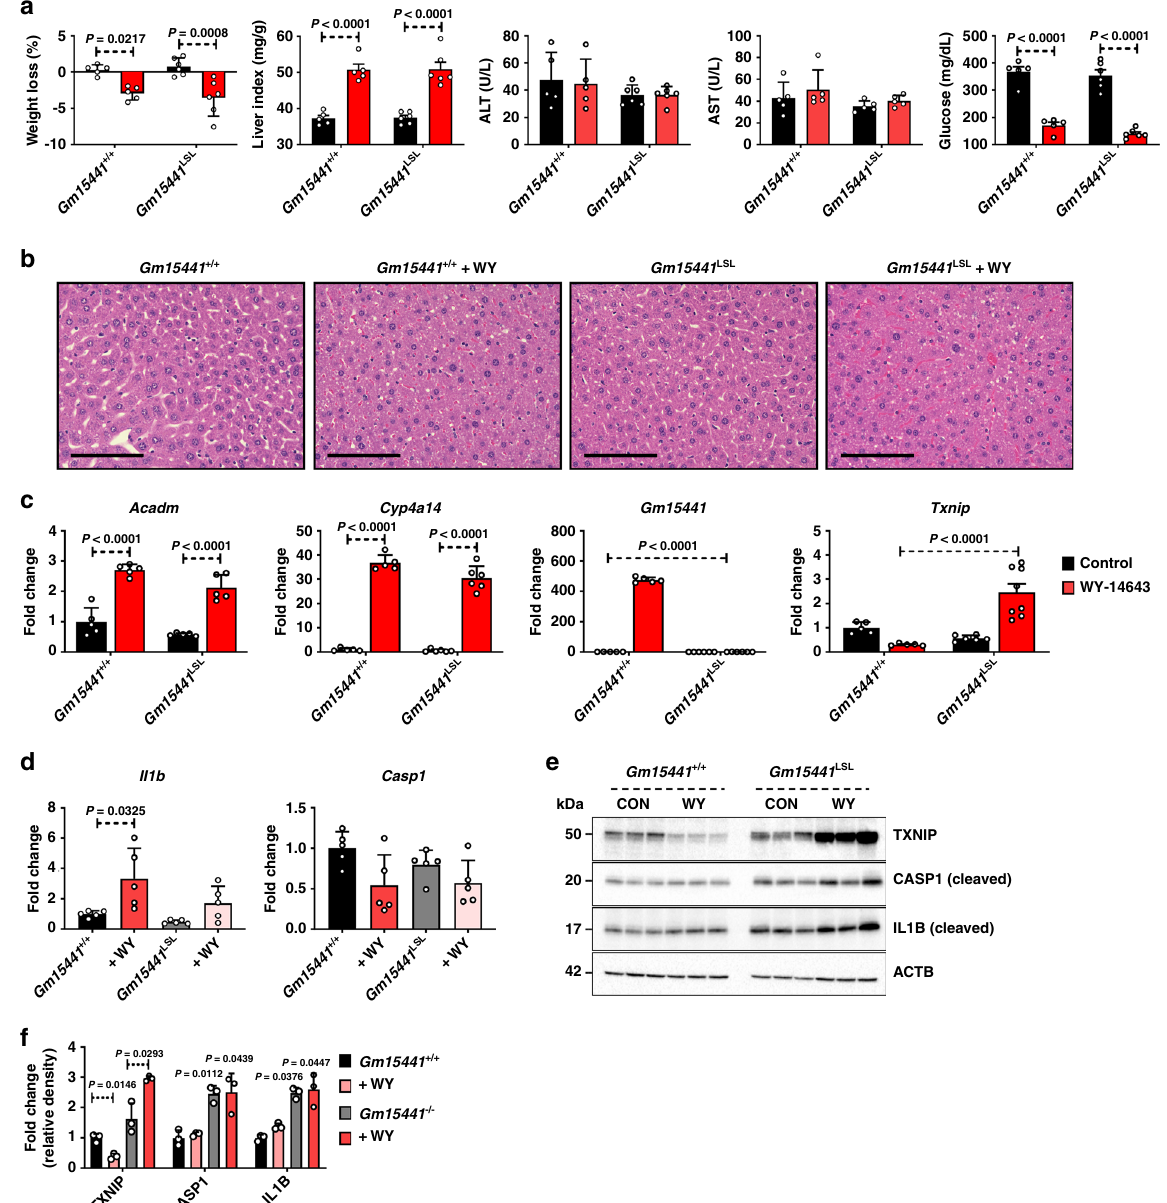
Fig. 5 Loss of Gm15441 potentiates in fl ammasome activation by WY-14643. a Physiological endpoints from Gm15441 + / + and Gm15441 LSL mice treated with WY-14643 for 48 h. Weight loss and liver indices (mg liver/g body mass; a measure of hepatomegaly), as well as serum ALT, AST, and glucose levels, in response to WY-14643 treatment. b Representative H&E staining from liver of Gm15441 + / + and Gm15441 LSL mice treated with WY-14643 for 48 h ( n = 5, 3 images/mouse). Scale bars represent 100 nm (×400). c qRT-PCR analysis of Acadm , Cyp4a14 , Txnip , and Gm15441 expression in livers of mice treated with WY-14643 for 48 h. d qRT-PCR analysis of Il1b and Casp1 mRNA in livers of mice treated with WY-14643. e Western blot analysis of TXNIP, ACTB, CASP1 (cleaved), and IL1B (cleaved) protein in livers from mice treated with WY-14643 for 48 h. f Densitometric analysis of TXNIP, CASP1 (cleaved), and IL1B (cleaved) protein levels ( n = 3). Each data bar represents mean ± SD for n = 5 liver samples; red bars, WY-14643 treatment. Adjusted p values, provided in the panels, as determined by ANOVA with Tukey ’ s multiple comparison correction, two-sided for comparisons between WY-14643 and control livers of the same genotype, or as shown (dashed horizontal